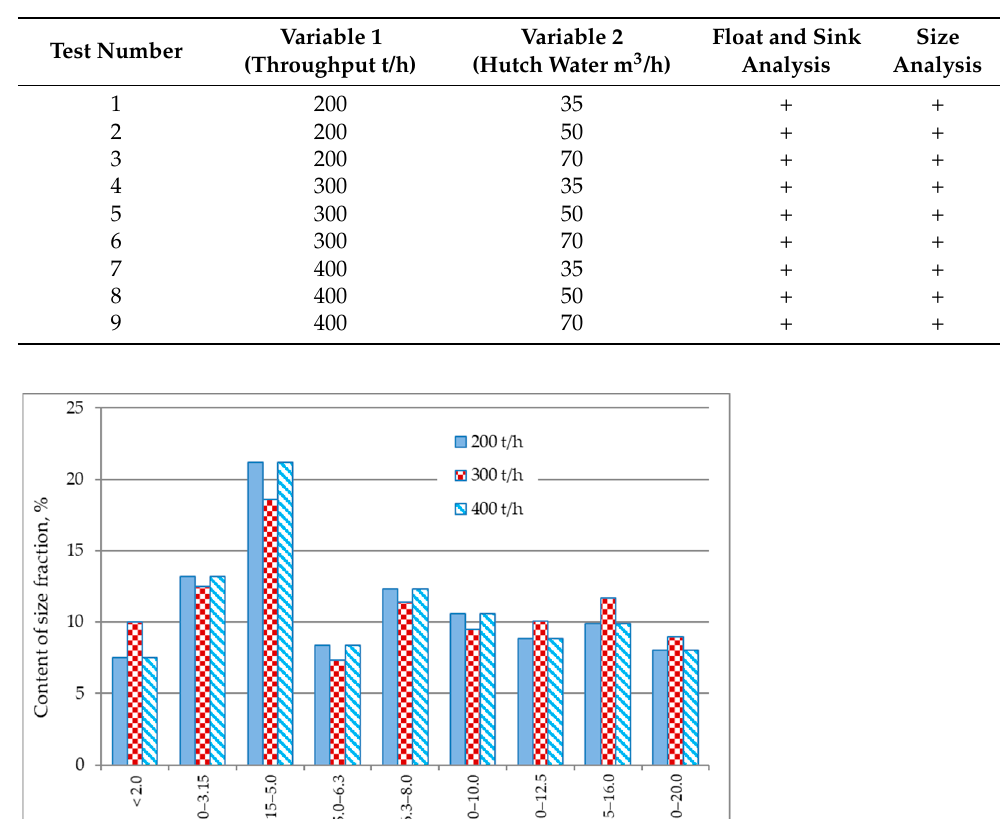
Table 1. Scheme of factor experiment.